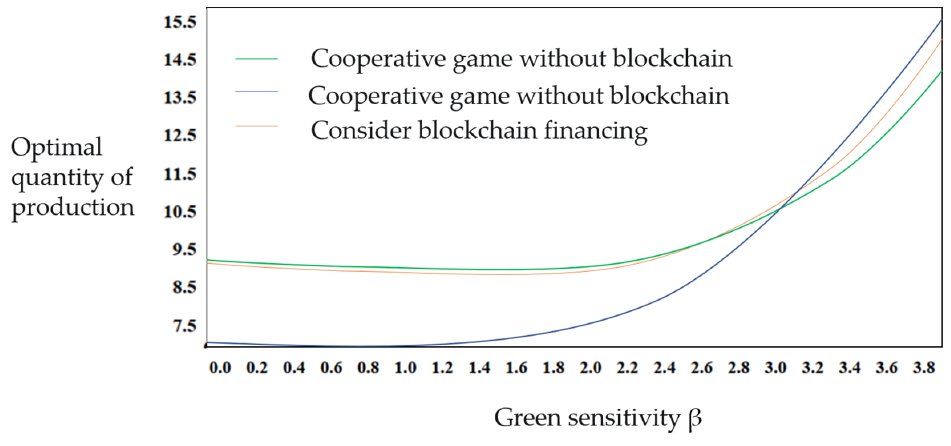
Figure 2. Optimal yield at di ff erent β .